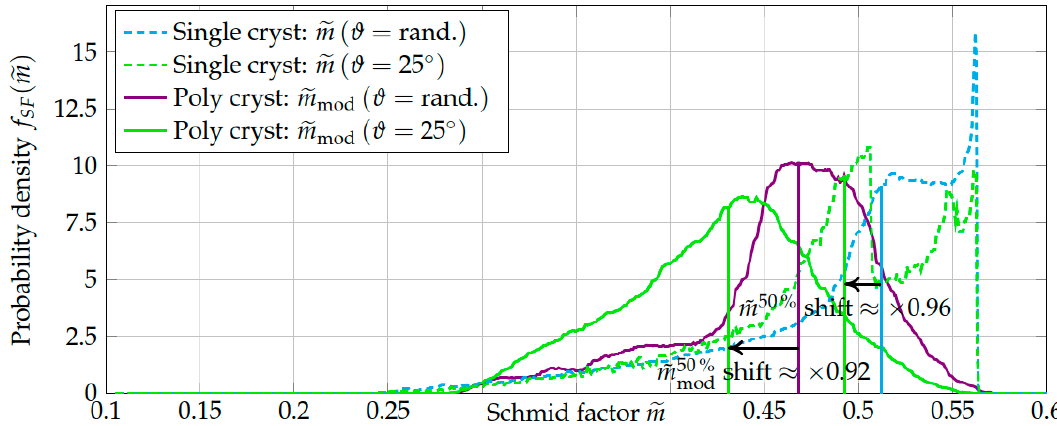
Figure 13. Comparison of the Schmid factor distribution density functions for a single crystal f SF ( (cid:101) m ) and a polycrystal f SF ( (cid:101) m mod ) (from FEA). The random Euler angle ϑ (coarse grain batch) refers to isotropically and ϑ = 25 ◦ (fine grain batch) refers to preferentially distributed grain orientations. A uniaxial stress was applied to all models. Vertical lines indicate the median values.